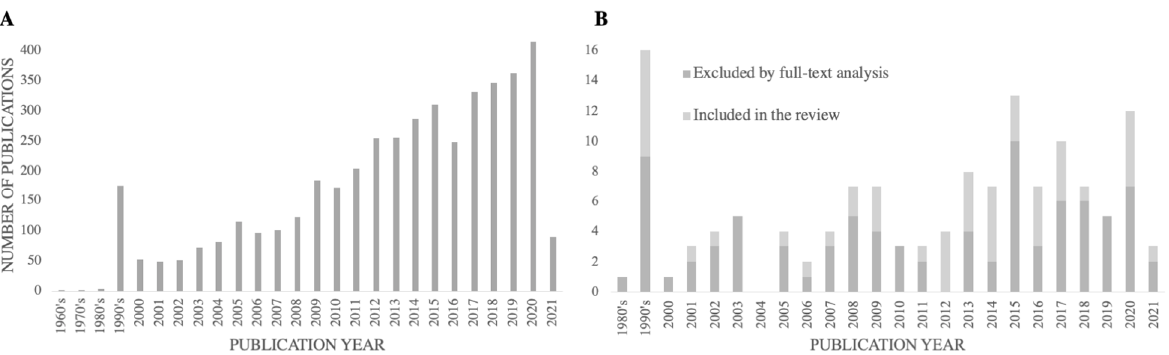
Figure 2. The number of studies retrieved by the database search, excluded by title and abstract screening ( A ), and excluded or included by full-text analysis ( B ), by publication year.